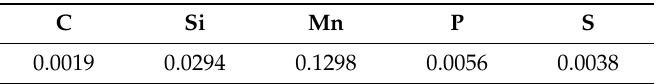
Table 1. The chemical composition of Armco-type pure iron